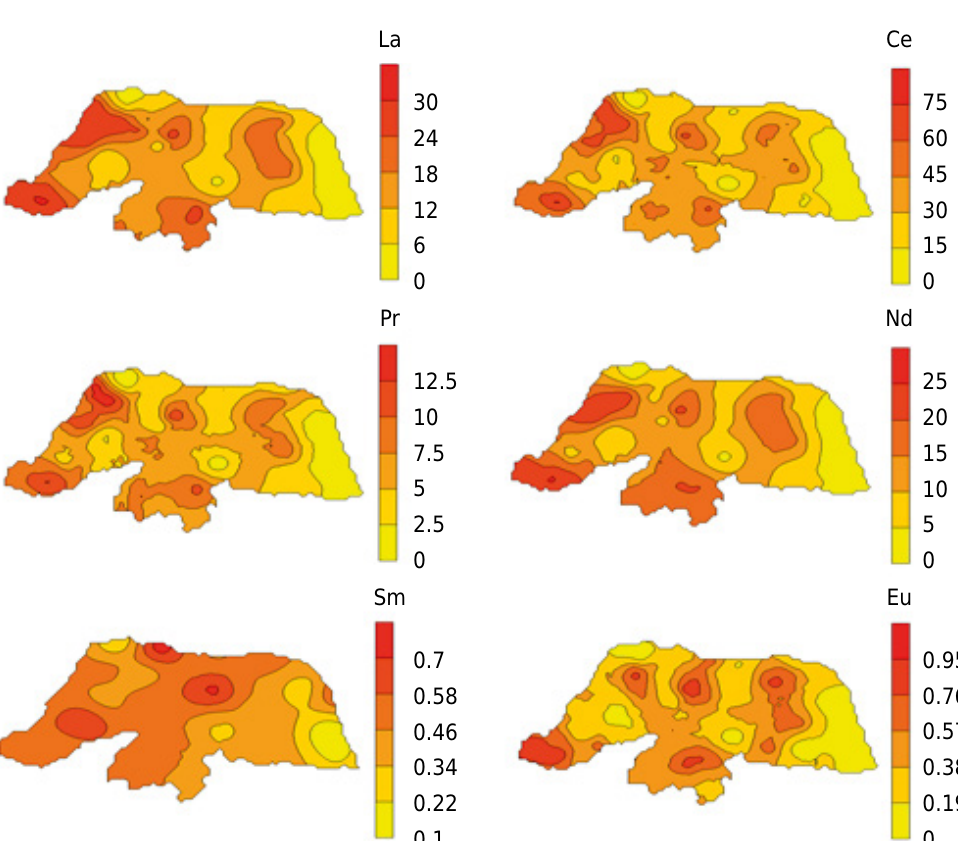
Figure 6. Spatial distribution of LREEs (mg kg -1 ) in soils from Rio Grande do Norte, Brazil.